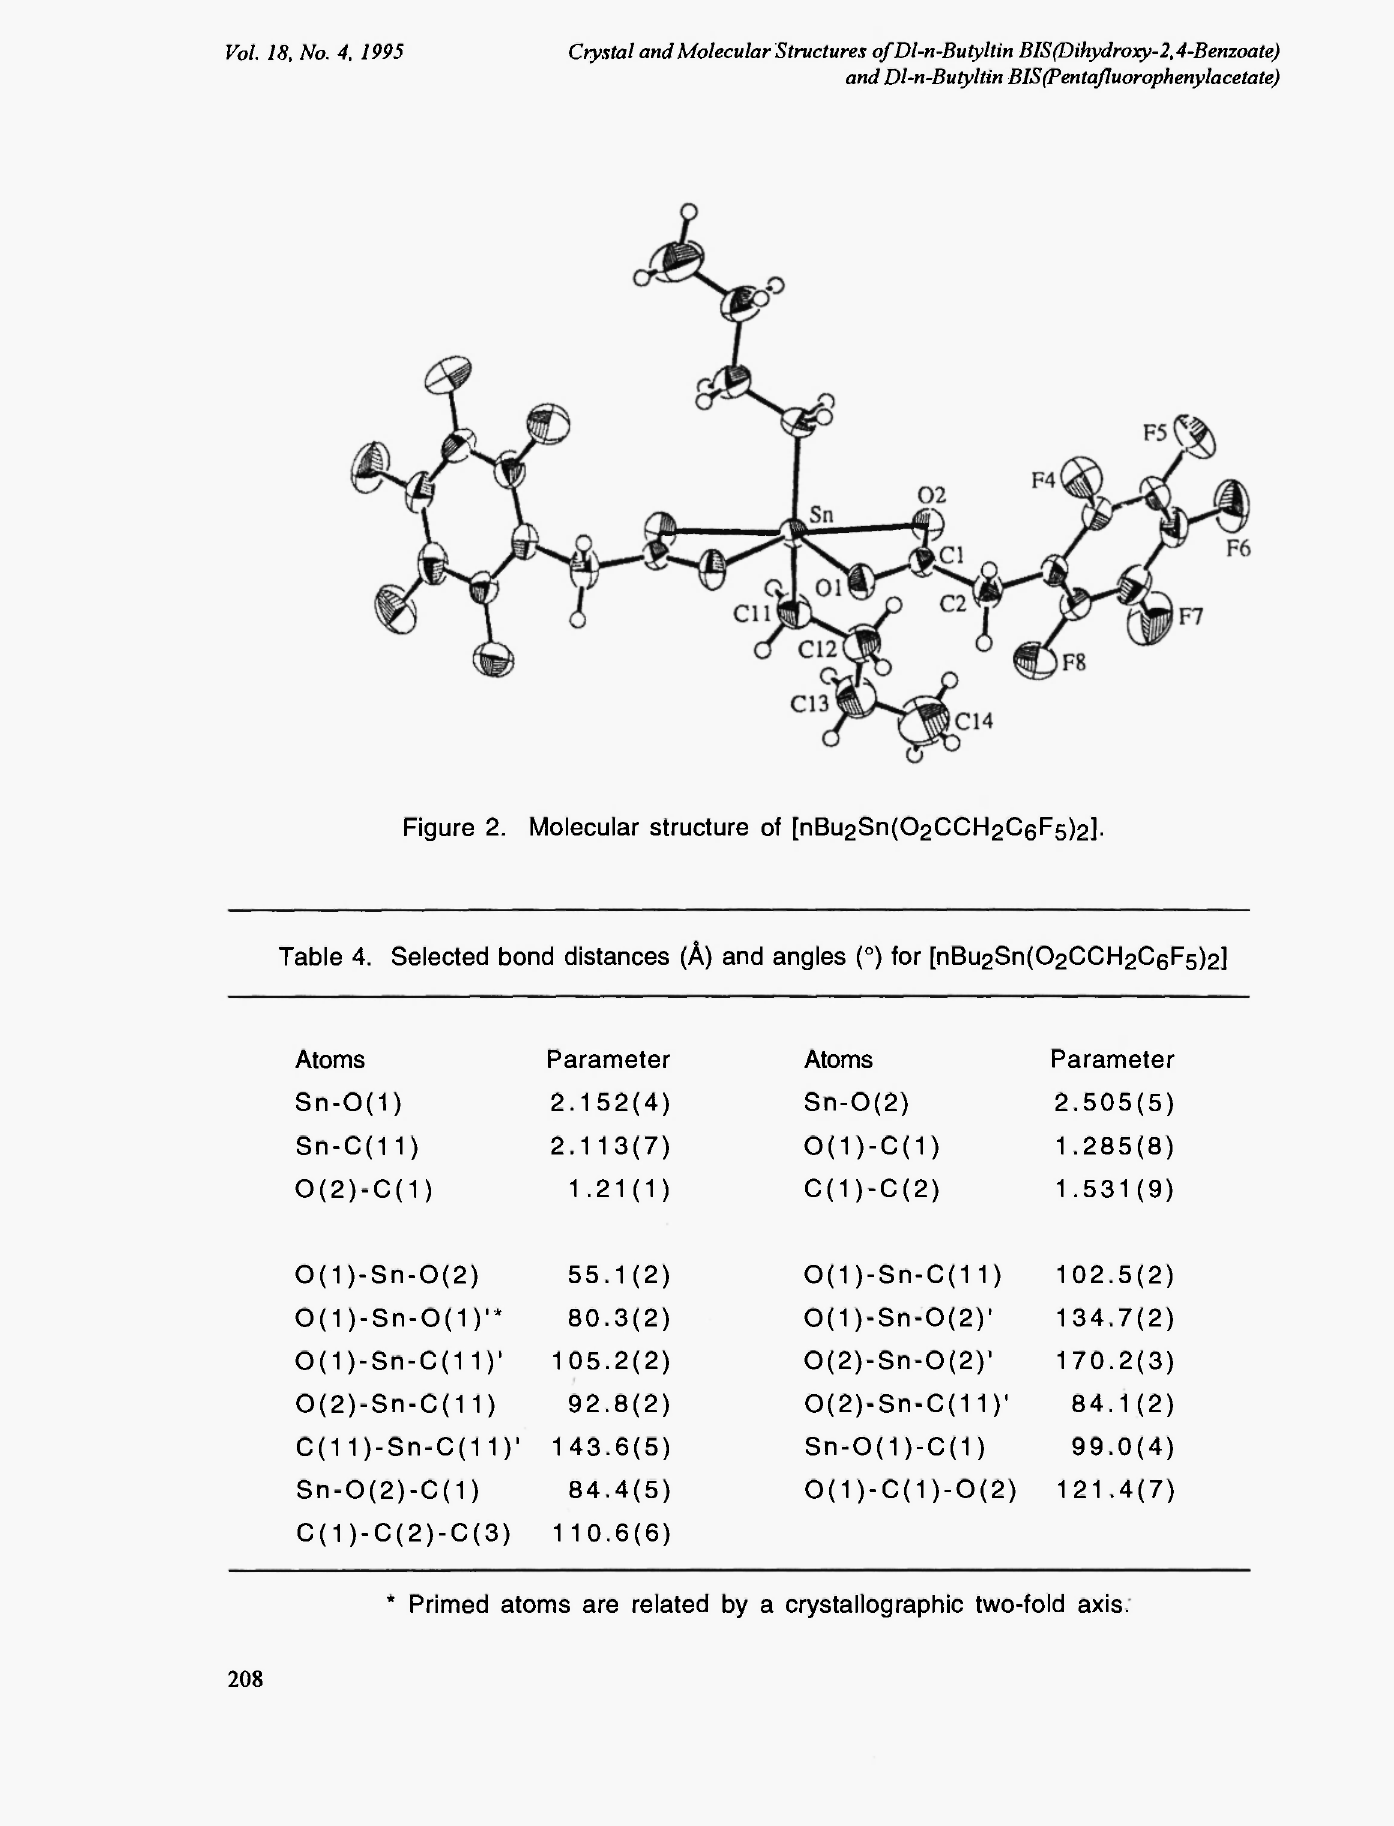
Figure 2. Molecular structure of [nBu2Sn(02CCH2C6F5)2].